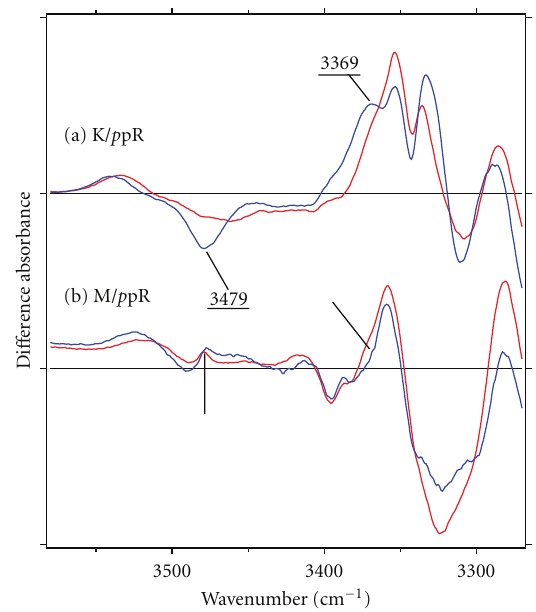
Figure 5: p pR minus p pR (a) and p pR minus p pR (b) infrared K M di ff erence spectra without (red lines) and with (blue lines) p HtrII in the 3580–3270 cm − 1 region. Spectra are measured at 77K (a) and 250 K (b) upon hydration with D 2 O. The original data appeared in